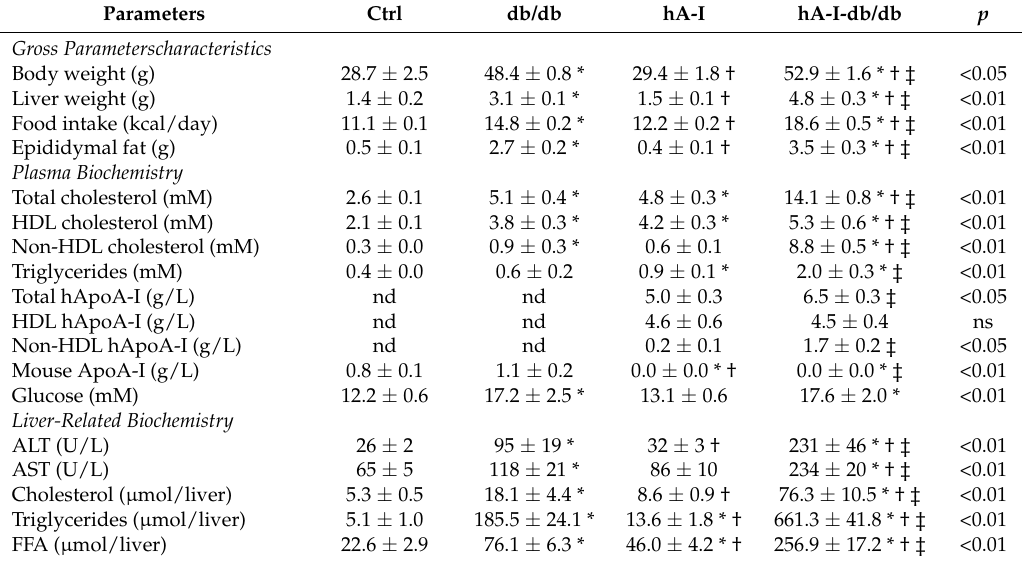
Table 1. Impact of human apolipoprotein A1 (hApoA-I) overexpression on gross and biochemical parameters in db/db